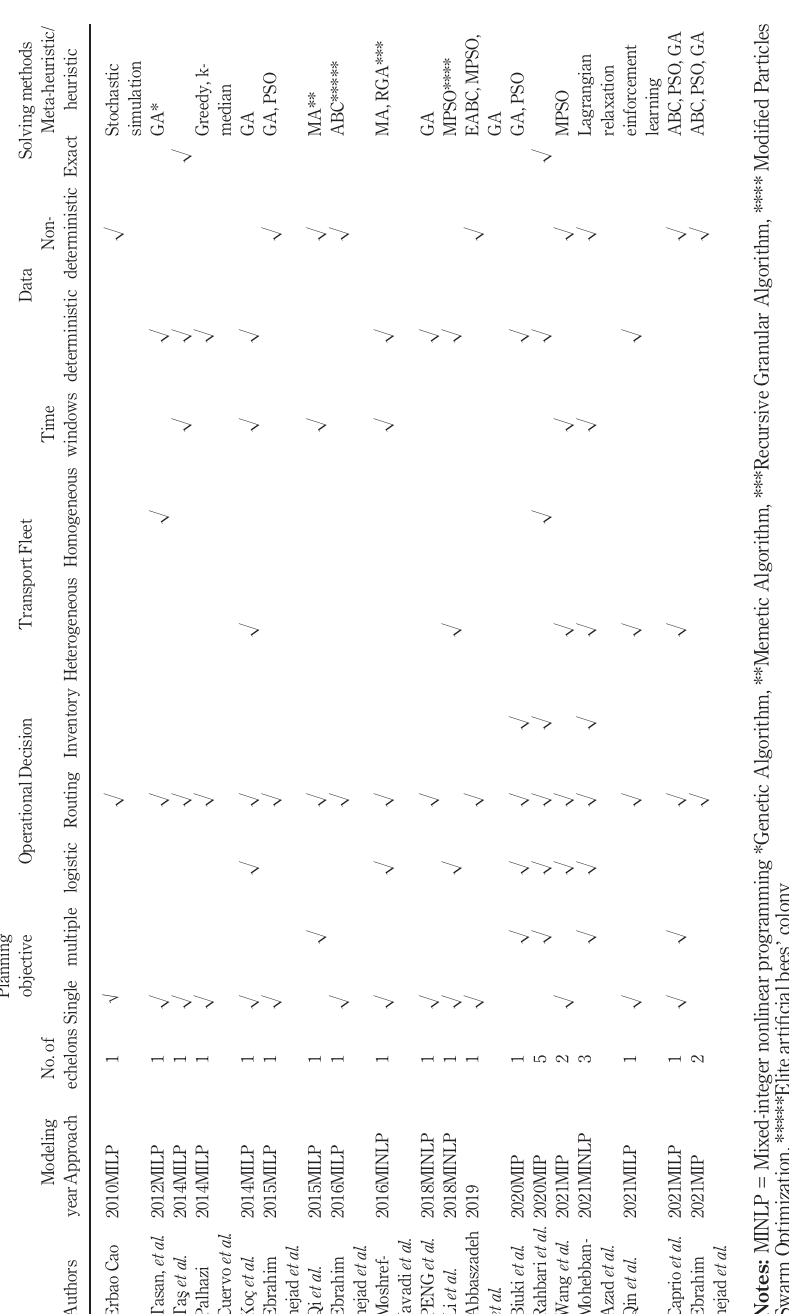
Table 1. Overview of the literature on location- routing